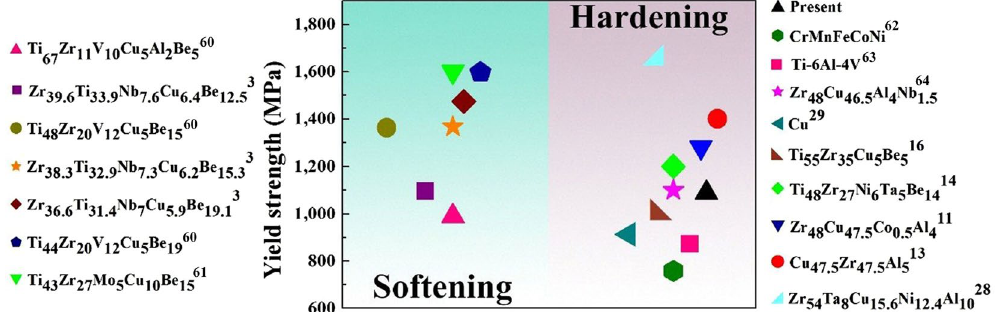
Figure 6. Alloys with different deformation behaviors upon